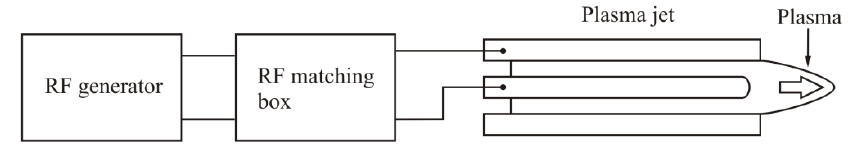
Figure 13. Block diagram of the RF-frequency power supply of atmospheric pressure plasma jets (APPJ).